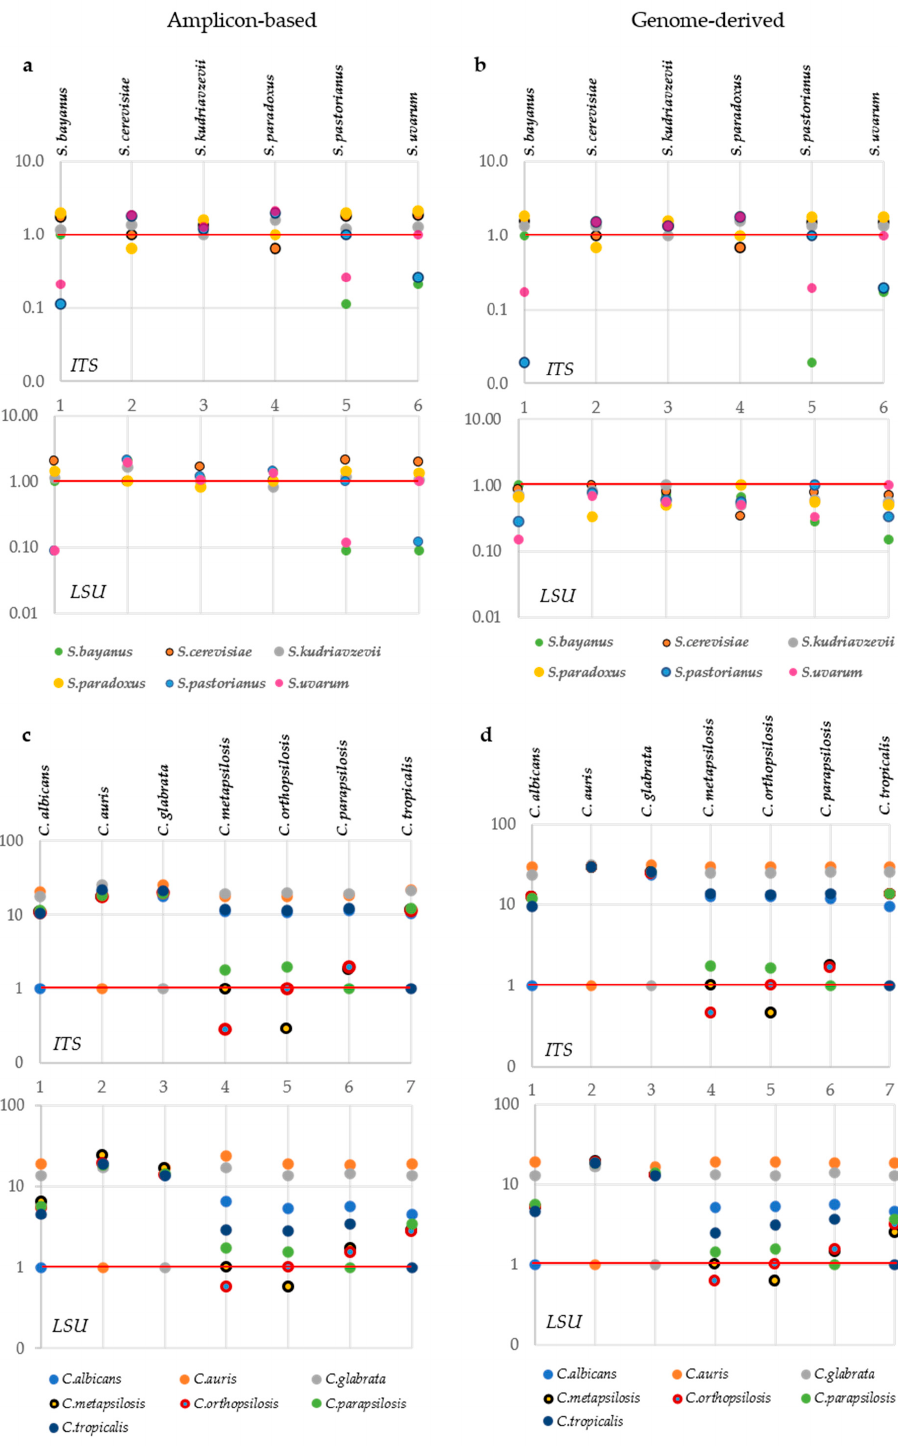
Figure 3. Mean Taxonomic Resolution ( MeTRe ) among and within the Saccharomyces and Candida species. Resolution calculated for Saccharomyces standard and genomic ITS and LSU are displayed in panels ( a , b ), respectively. Amplicon-based and genomic resolution of the Candida ITS and LSU markers are reported in panels ( c , d ). Each column shows the resolution of the species positioned in a red line (reported above each column) from the other species under analysis. The species placed below the red line were not resolved by the marker from the species reported above each column. Values of MeTRe in log scale are reported on the y-axis, while numbers on the x-axis correspond to the species involved in the study (and are depicted at the beginning of each